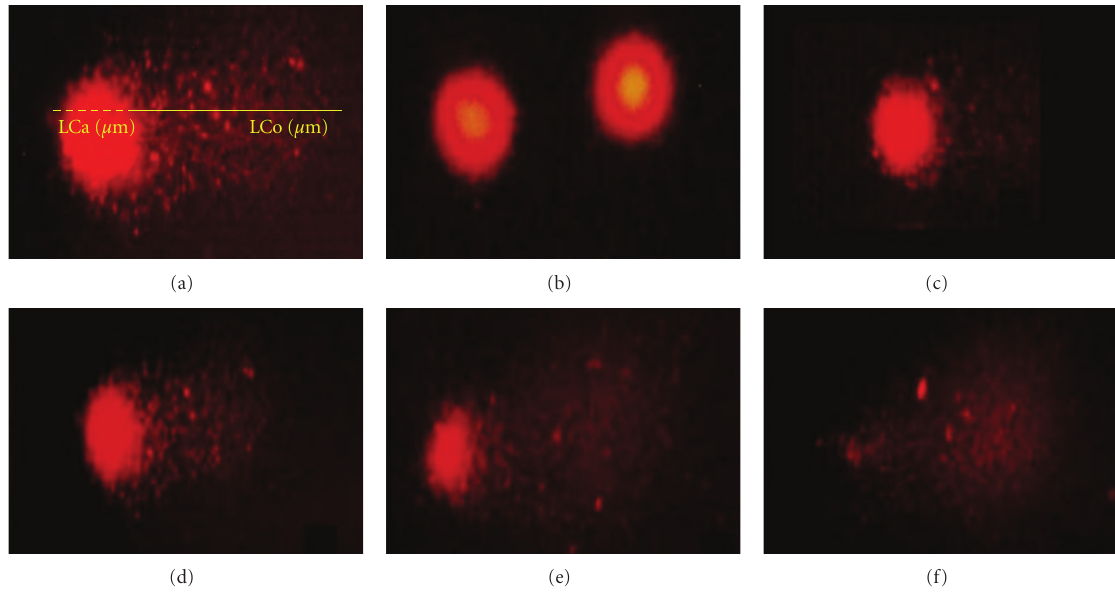
Figure 1: Comet classification. (a) Comet measurement, (b) no damage, (c) low damage, (d) medium damage, (e) high damage, and (f) total damage. The fluorochromization was performed with ethidium bromide and fluorescence microscope (1000x).